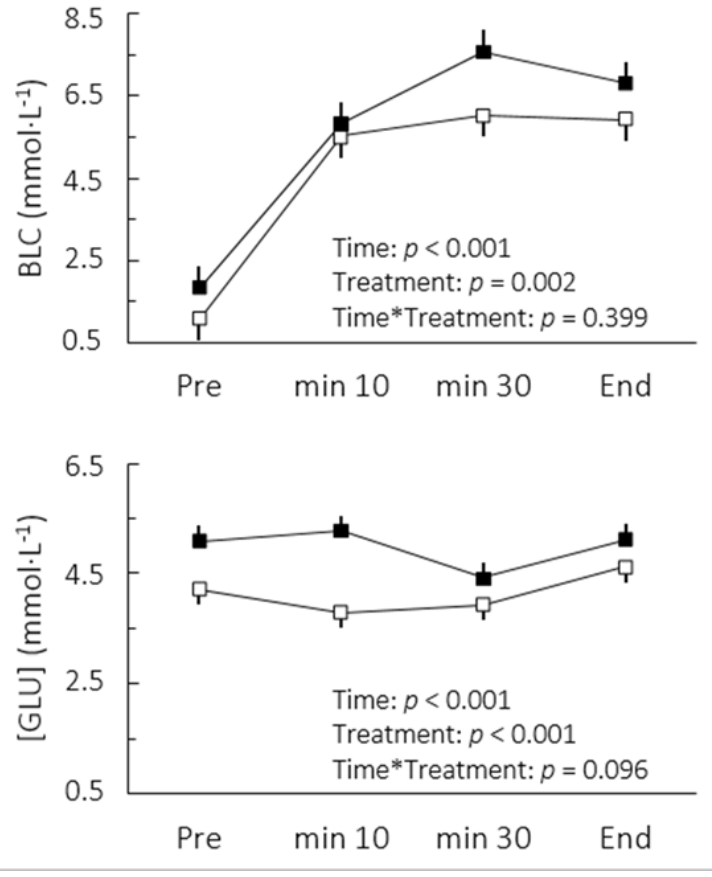
Figure 1. Blood lactate (BLC) and glucose ([GLU]) concentrations after caffeine ( ▪ ) and placebo ( ▫ ) ingestion during cycling to exhaustion at maximal lactate steady state. Values are mean ± SE.